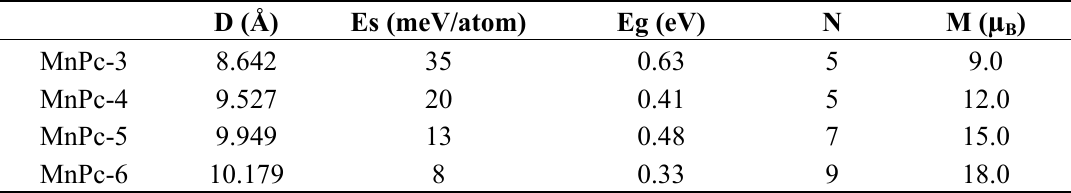
Table 1. Typical parameters characterizing the atomic and electronic structures of MnPc nanotubes, where D is the Mn-Mn distance perpendicular to the tube axis; Es is the strain energy; Eg is the spin-up band gap; N is the number of spin-down energy bands across the Fermi level and M is the magnetic moment per unit